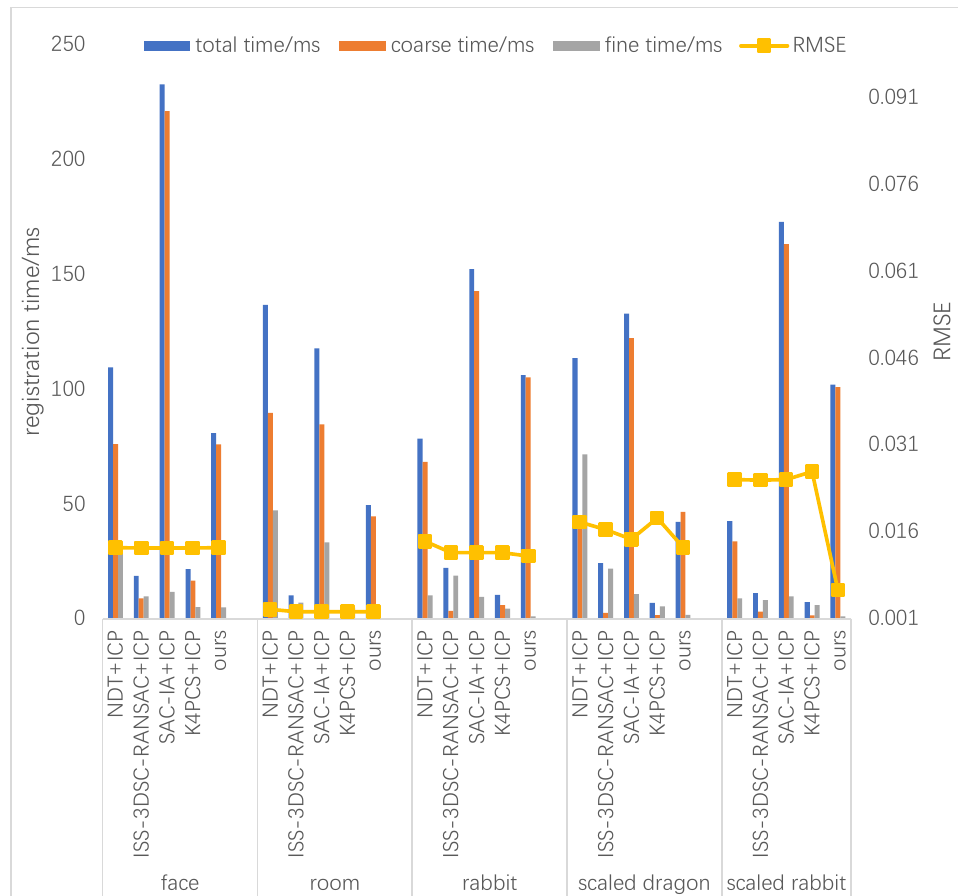
Figure 11. The registration performance records of testing data sets with five coarse-to-fine registra- tion methods.